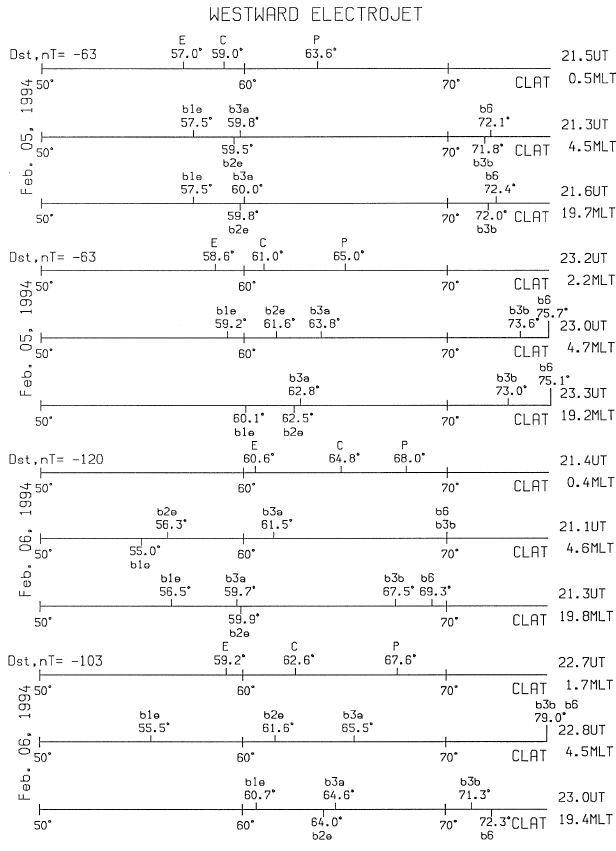
Fig. 7. Similar to Fig. 5 for westward electrojets on February 05–06, 1994 at near midnight MLT hours and location of plasma domain boundaries at the evening and morning